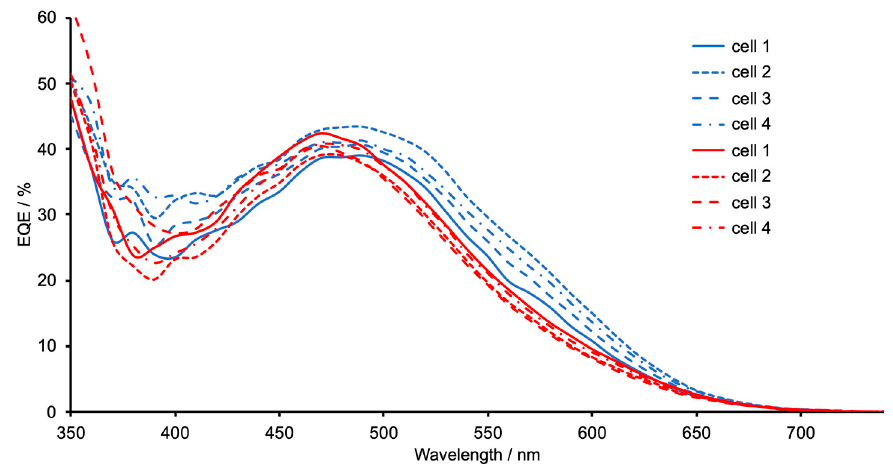
Figure 11. EQE spectra for sets of four DSCs sensitized with [Cu( 5 )( 3 )] + (blue curves) and [Cu( 5 )( 4 )] + (red curves) measured on the day of sealing the cells.